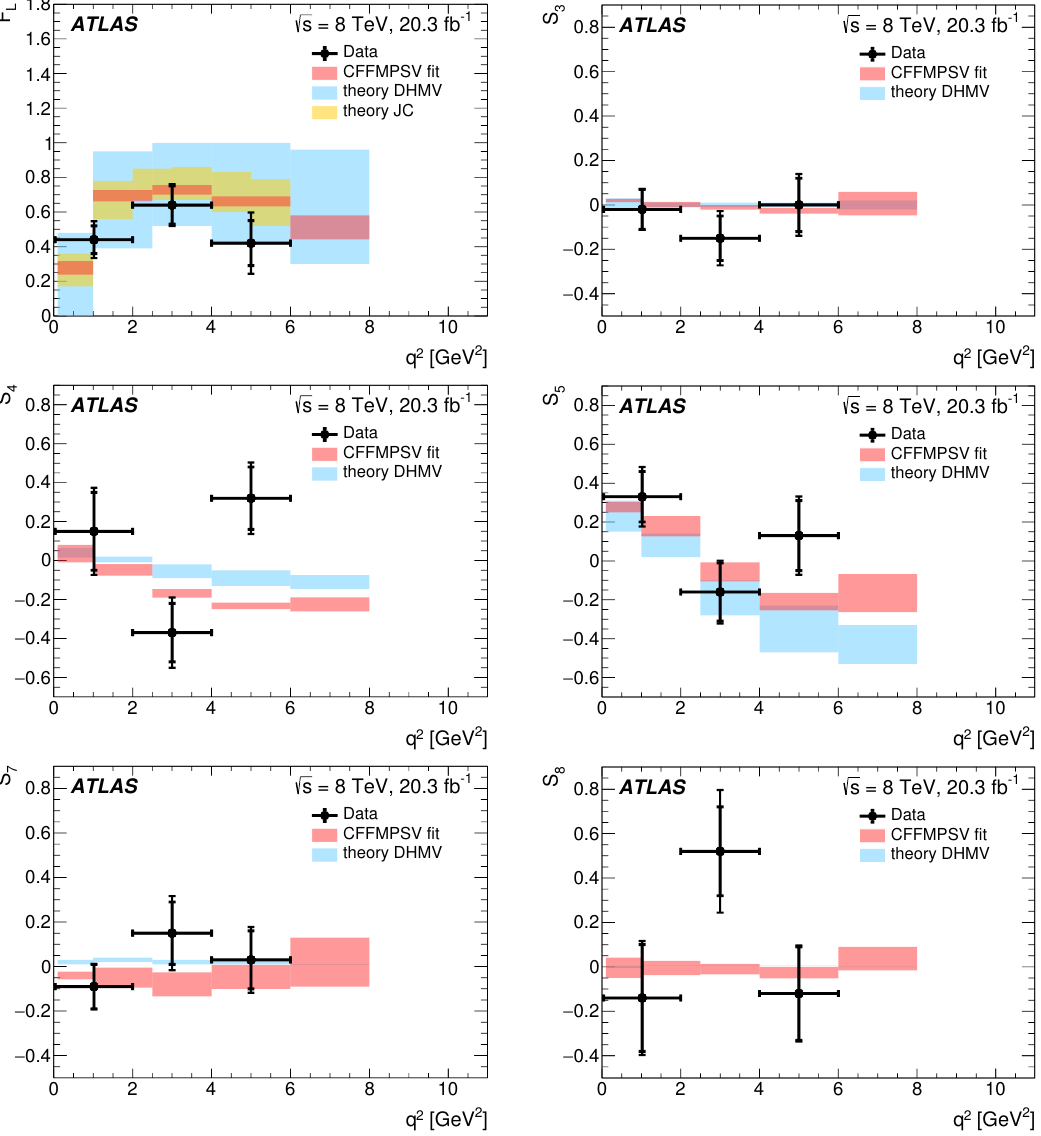
, S , S , S , S , S compared with predictions from the L 3 4 5 7 8